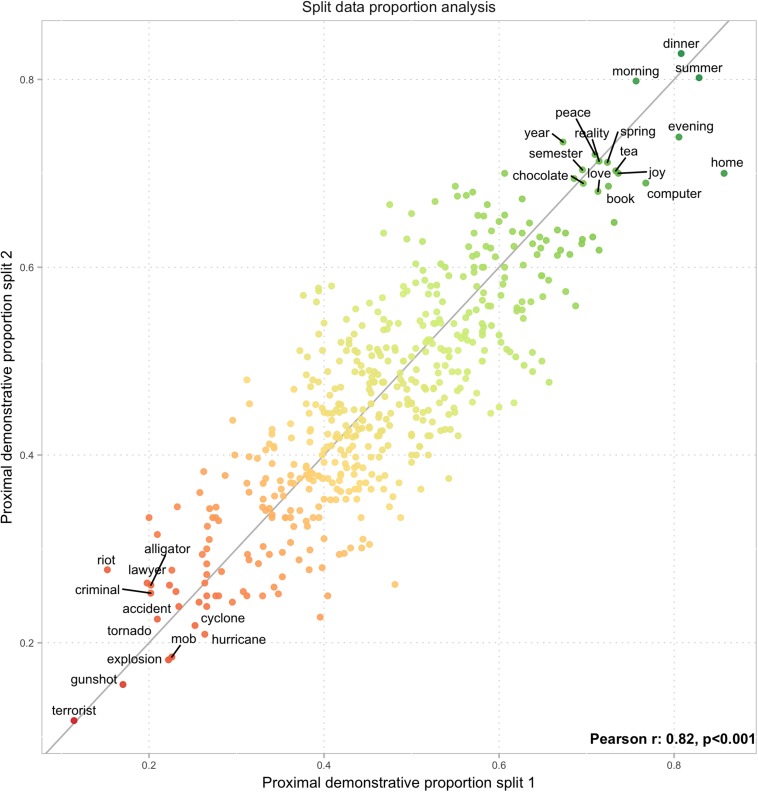
Aggregate proportion of proximal demonstratives in two data splits show a high degree of reproducibility (r = 0.82) in aggregate demonstrative choices for words across semantic categories. Words deviating more than two standard deviations from mean aggregate proportion are reproduced. Valence effect is clearly visible; negative effect of words denoting loudness as well as a positive effect of words relating to temporal events also seem to be visible.